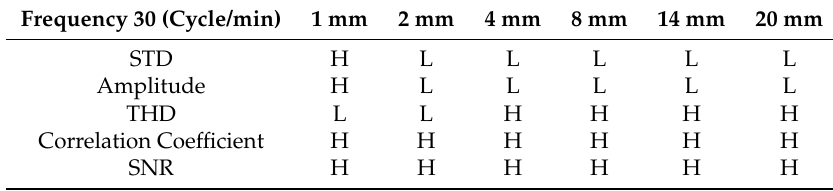
Table A10. Values higher and lower than the median Frequency 30 cycles/min for a 3 mm